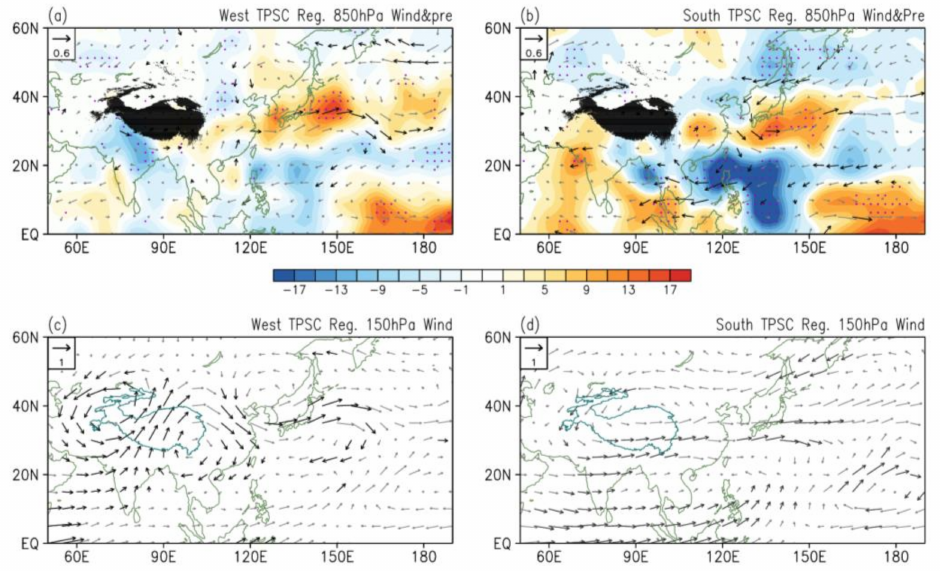
Figure 3. Anomalies of June-July-August 850-hPa winds (m/s) and precipitation (mm/month) ( a , b ) and 150-hPa winds (m/s) ( c , d ) obtained by linear regression against the June–July–August interannual snow cover index in ( a , c ) the west TP region (32.5 ◦ N–40.5 ◦ N, 70 ◦ E–79 ◦ E) and ( b , d ) the south TP region (26.5 ◦ N–31.5 ◦ N, 80 ◦ E–99 ◦ E) for the period 1979–2020. Dotted regions denote precipitation anomalies significant at the 95% confidence level, and black vectors denote wind anomalies significant at the 95% confidence level. The scale for wind vectors are shown in the upper-left corner. Cyan curves in ( c , d ) denote the region with elevation above 2000 m. Black shading in ( a , b ) denotes the elevation below 2000 m. The analysis is based on the NSIDC snow